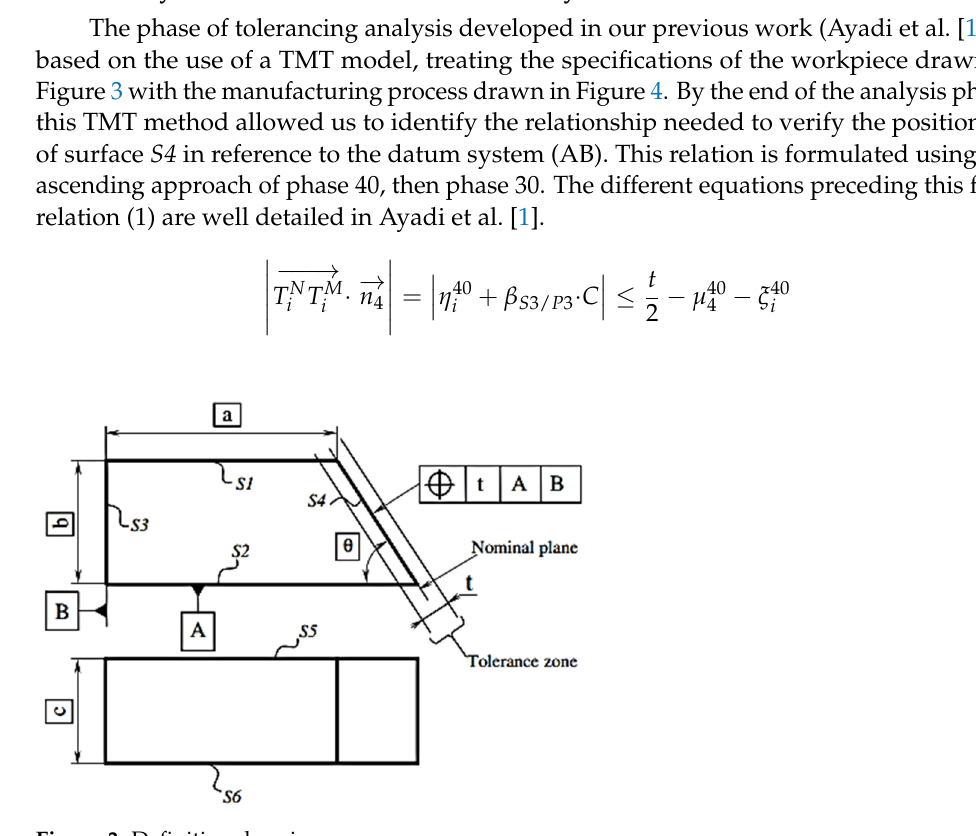
Figure 3. Definition drawing.